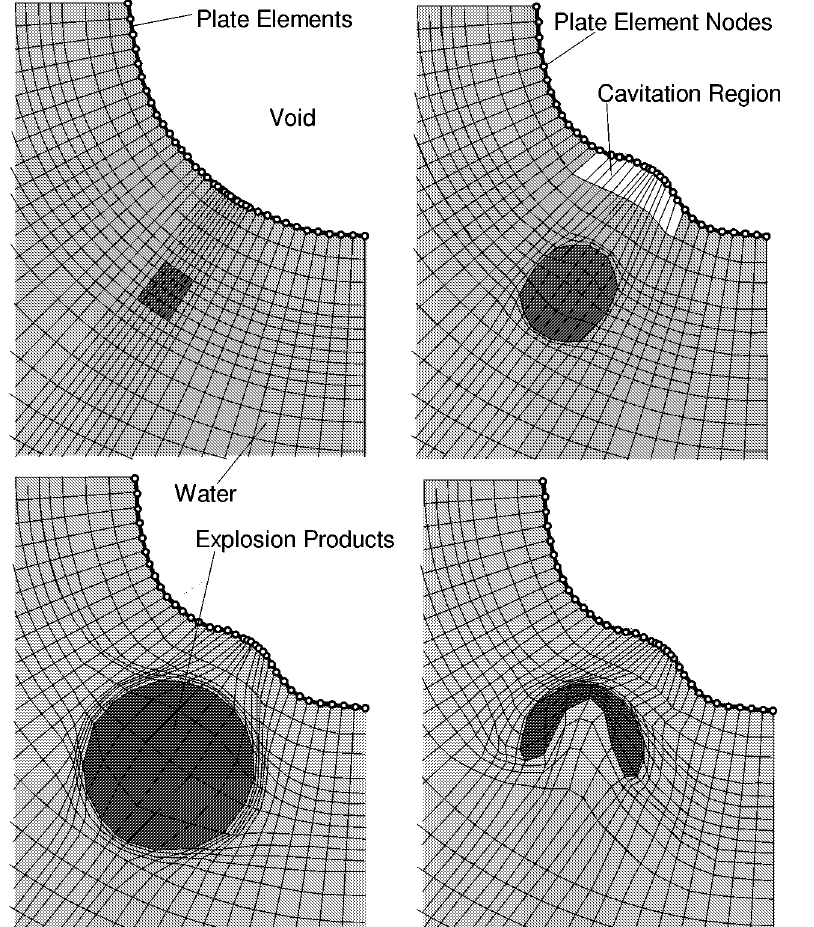
Fig. 2. Lagrangian hydrocode UNDEX-SMI